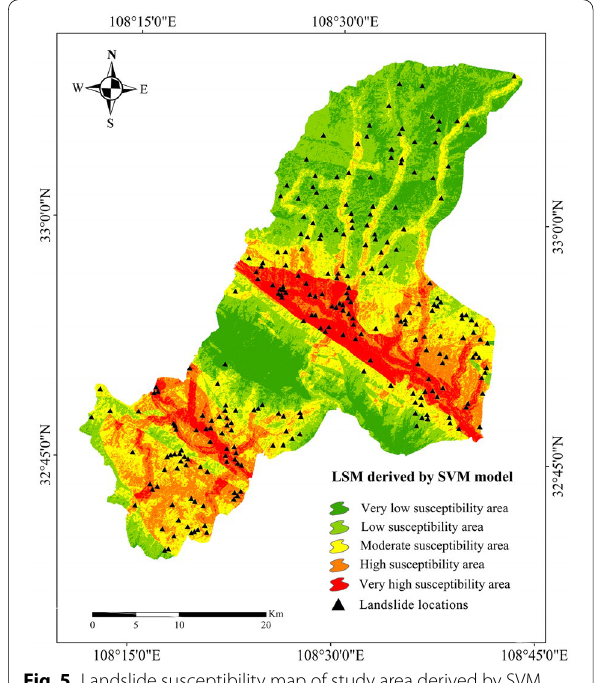
Fig. 5 Landslide susceptibility map of study area derived by SVM